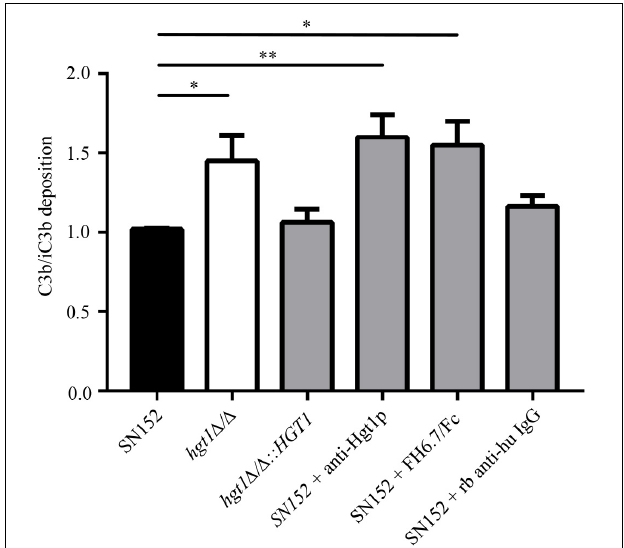
FIGURE 5 | Decreased FH binding is associated with increased C3b/iC3b deposition on C. albicans. Relative C3b/iC3b deposition on SN152 parental (black bar), hgt1 (cid:49) / (cid:49) (white bar), hgt1 (cid:49) / (cid:49) ::HGT1 (complemented strain), each incubated with NHS, or on SN152 incubated with anti-Hgt1p or with the chimeric molecule FH6.7/Fc to block FH binding, or with irrelevant rabbit anti-human IgG. Data are expressed as MFI normalized to SN152 parental strain. Each bar represent the normalized mean + SD of five separate experiments ∗ p < 0.05, ∗∗ p < 0.01, by one-way ANOVA, using SN152 for